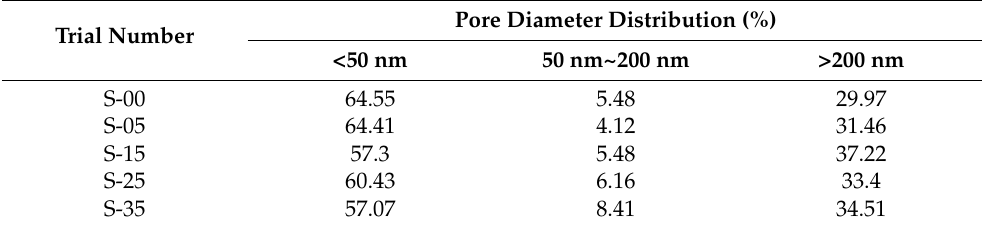
Table 3. Pore diameter distribution of the geopolymer mortar.